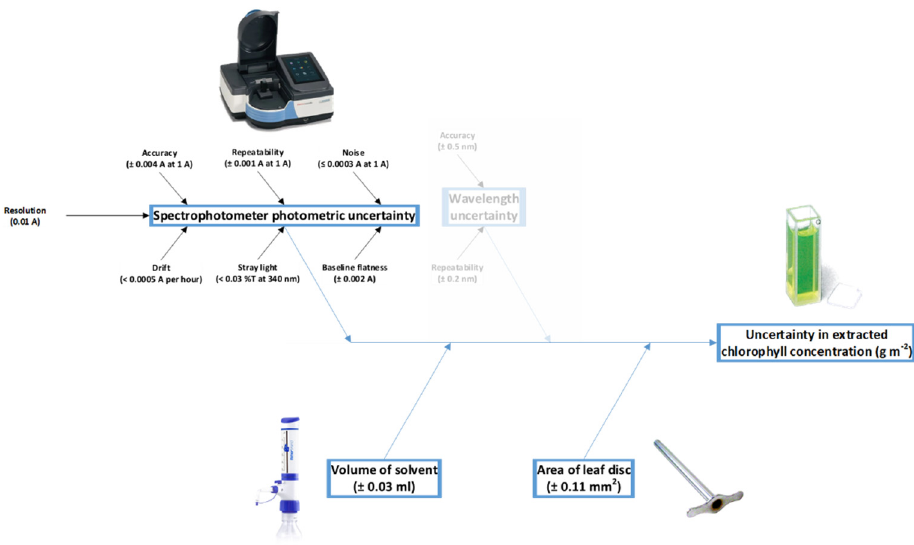
Figure 6. Uncertainty tree diagram illustrating the components contributing to uncertainty in spectrophotometrically-determined LCC [45,46]. The greyed out components were not considered due to their minimal contribution.